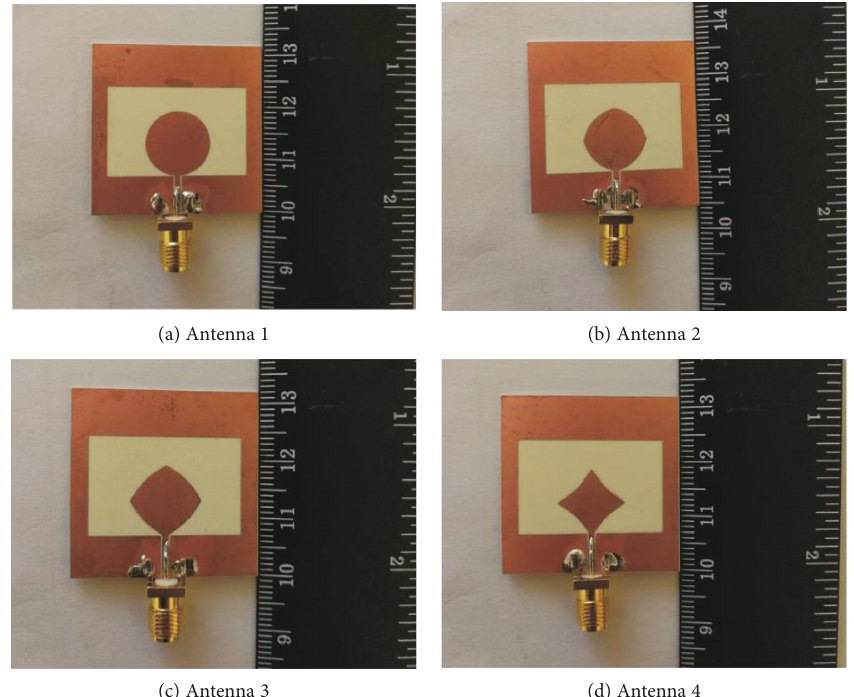
Figure 9: The fabricated antenna